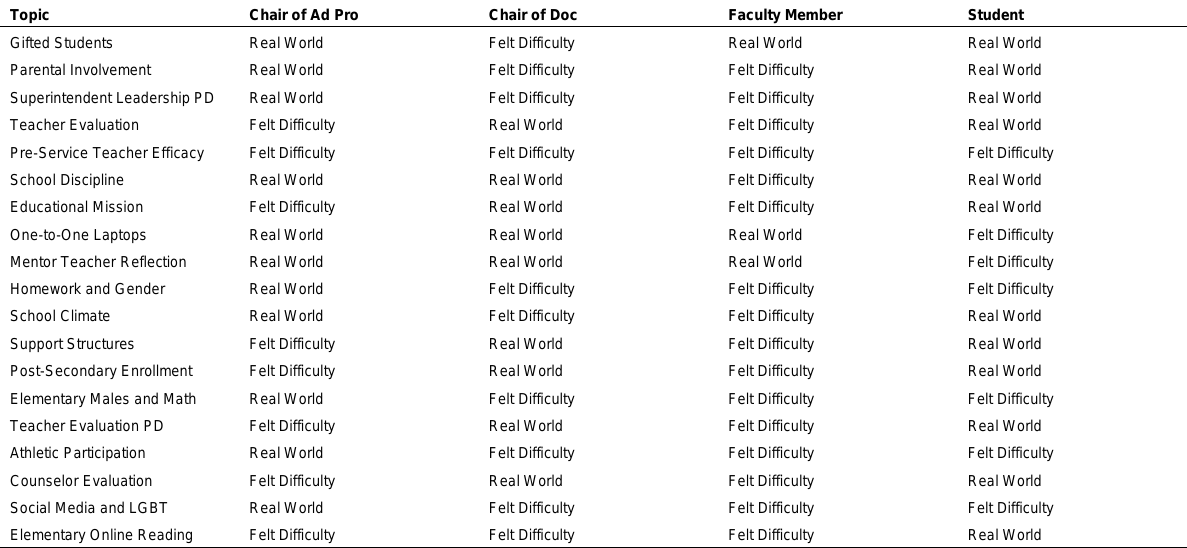
Table 2. Perception of Dissertation Problem of Practice by Researcher